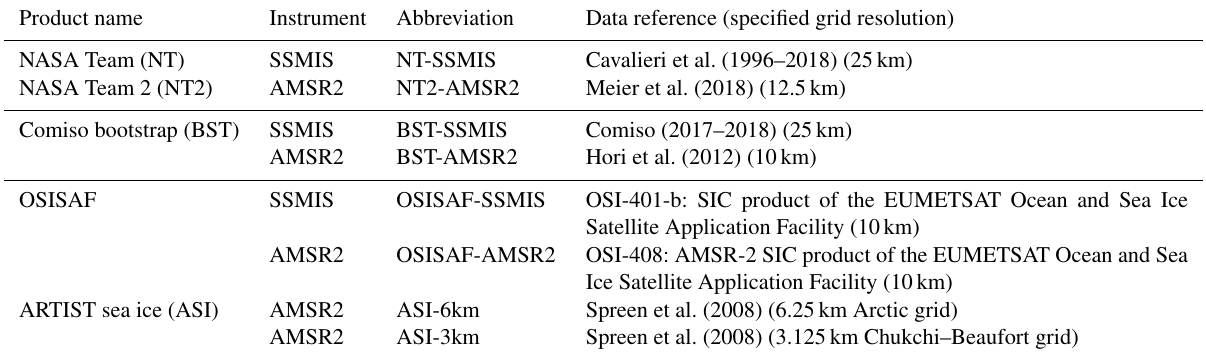
Table 1. Details of satellite-retrieved SIC products used in this